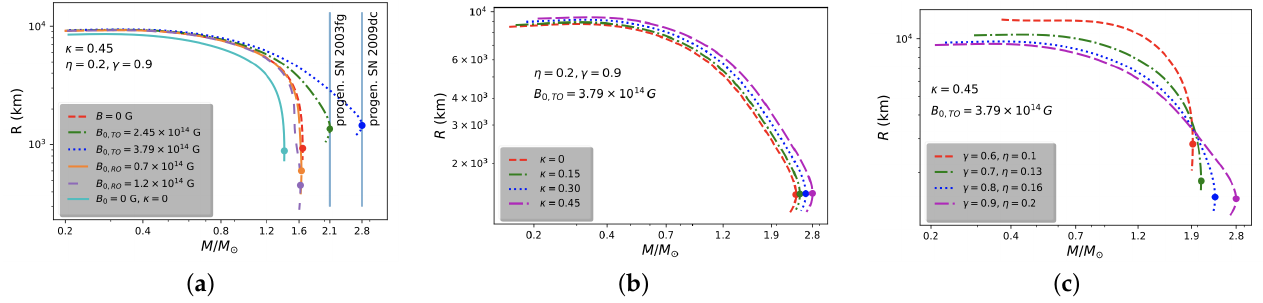
Figure 10. Stellar radius ( R ) as a function of gravitational mass ( M / M (cid:12) ) for different ( a ) B 0 (left panel), ( b ) κ (middle panel), and ( c ) η and γ (right panel). Solid circles represent the stars with the maximum- possible masses. See